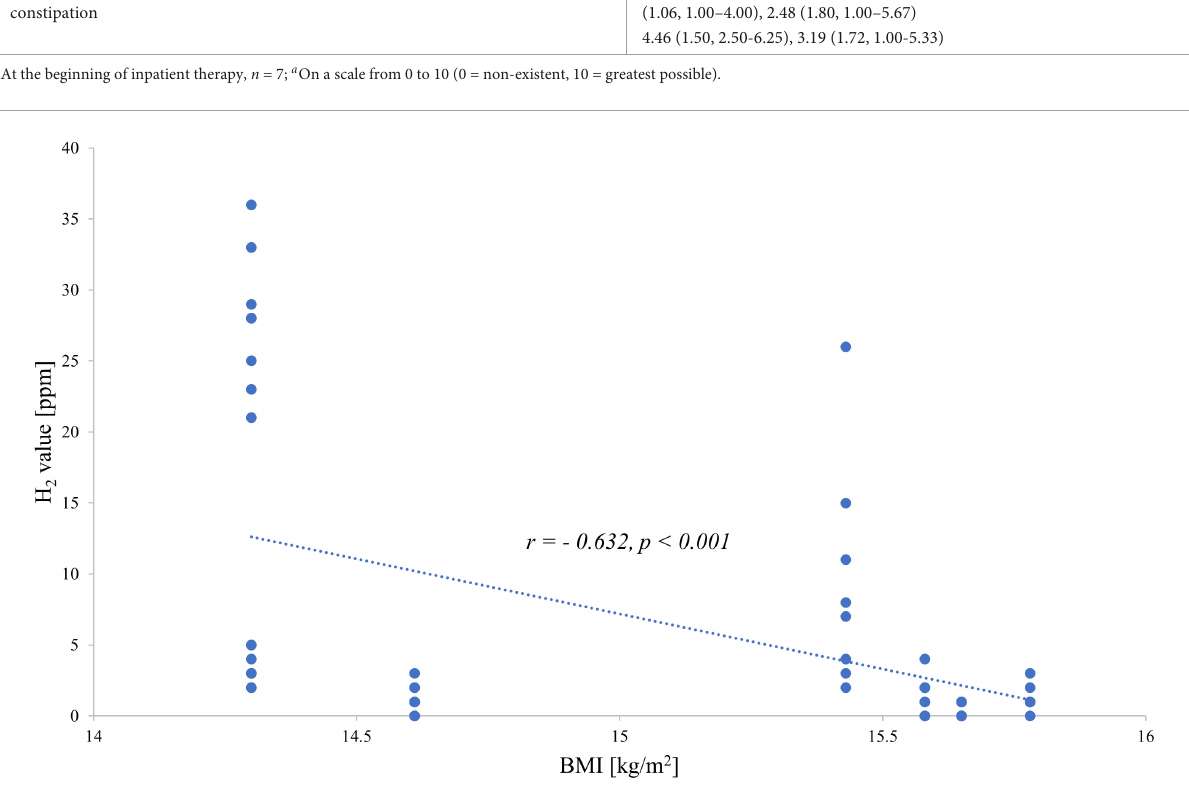
the mentioned anorexic group and patients with a somatoform disorder (33). Anxiety was reported as mild (mean GAD-7 score: 7.1) (25), and therefore higher compared with the general population (34) but lower than previously reported in patients with AN (7). Depressive symptoms (PHQ-9, score 0–4: minimal, score 5–9: mild, score 10–14: moderate, score 15–19: moderately severe, scale 20–27: severe) (35) were reported to be moderate in the current sample (mean PHQ-9 score: 11.3) consistent with a previous study on patients with AN (7). The